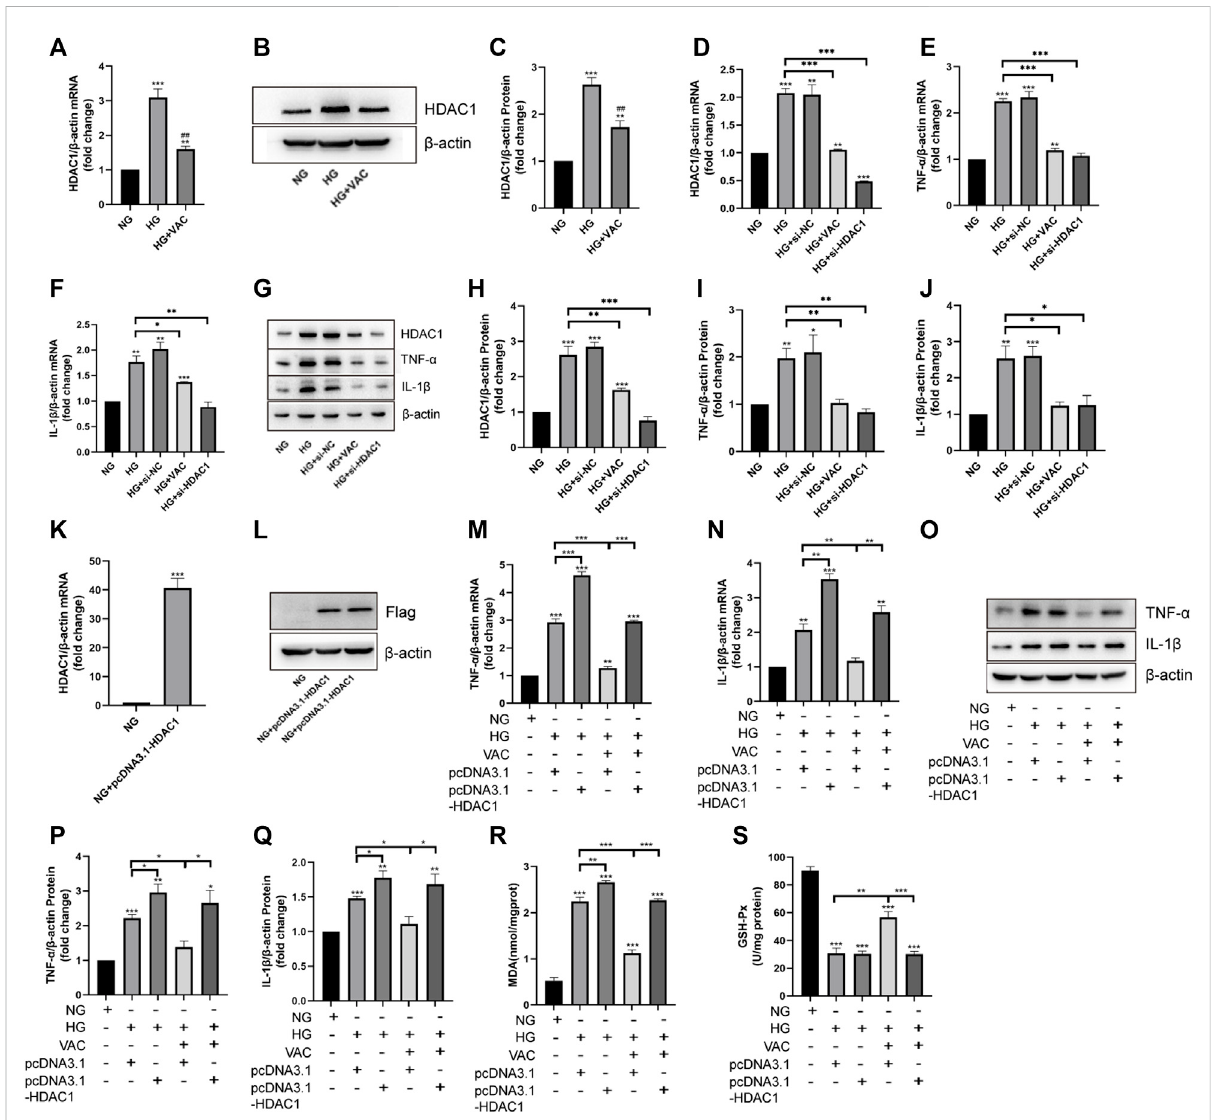
FIGURE 5 Vaccarin alleviated HG-induced in fl ammatory injury in HUVEC cells by inhibiting HDAC1 expression. (A) . The effects of vaccarin on HDAC1 mRNA expression in HG-induced HUVEC cells. (B,C) . Western blotting analysis of HDAC1 protein expression levels in HG-induced HUVEC cells. Gray value of western blotting. (D – F) . The expression of HDAC1 mRNA, TNF- α mRNA, and IL-1 β mRNA in HUVEC cells transfected with siRNA NC or HDAC1 siRNA. (G – J) . Western blotting analysis of HDAC1, TNF- α , and IL-1 β protein expression levels in HUVEC cells transfected with siRNA NC or HDAC1 siRNA. Gray value of western blotting. (K) . The expression of HDAC1 mRNA in HUVEC cells transfected with pcDNA3.1-HDAC1. (L) . Western blotting analysis of Flag protein expression levels in HUVEC cells transfected with pcDNA3.1-HDAC1. (M,N) . The effects of vaccarin on TNF- α mRNAandIL-1 β mRNA expressioninHUVECcellstransfectedwithpcDNA3.1orpcDNA3.1-HDAC1. (O – Q) .Western blottinganalysis ofTNF- α and IL-1 β protein expressionlevels inHUVEC cells transfected with pcDNA3.1 or pcDNA3.1-HDAC1. Gray value ofwestern blotting. (R) . Content of MDA. (S) .ActivityofGSH-Px.Valuesaremean±SEM.n=3ineachgroup.* p < 0.05,** p < 0.01,*** p < 0.001vs.NG; # p < 0.05, ## p < 0.01, ### p < 0.001 vs.